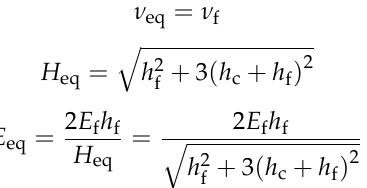
Figure 2. Unit cell structure diagram of metamaterial plate ( a ) a unit cell front view and ( b ) honey- comb core structure.